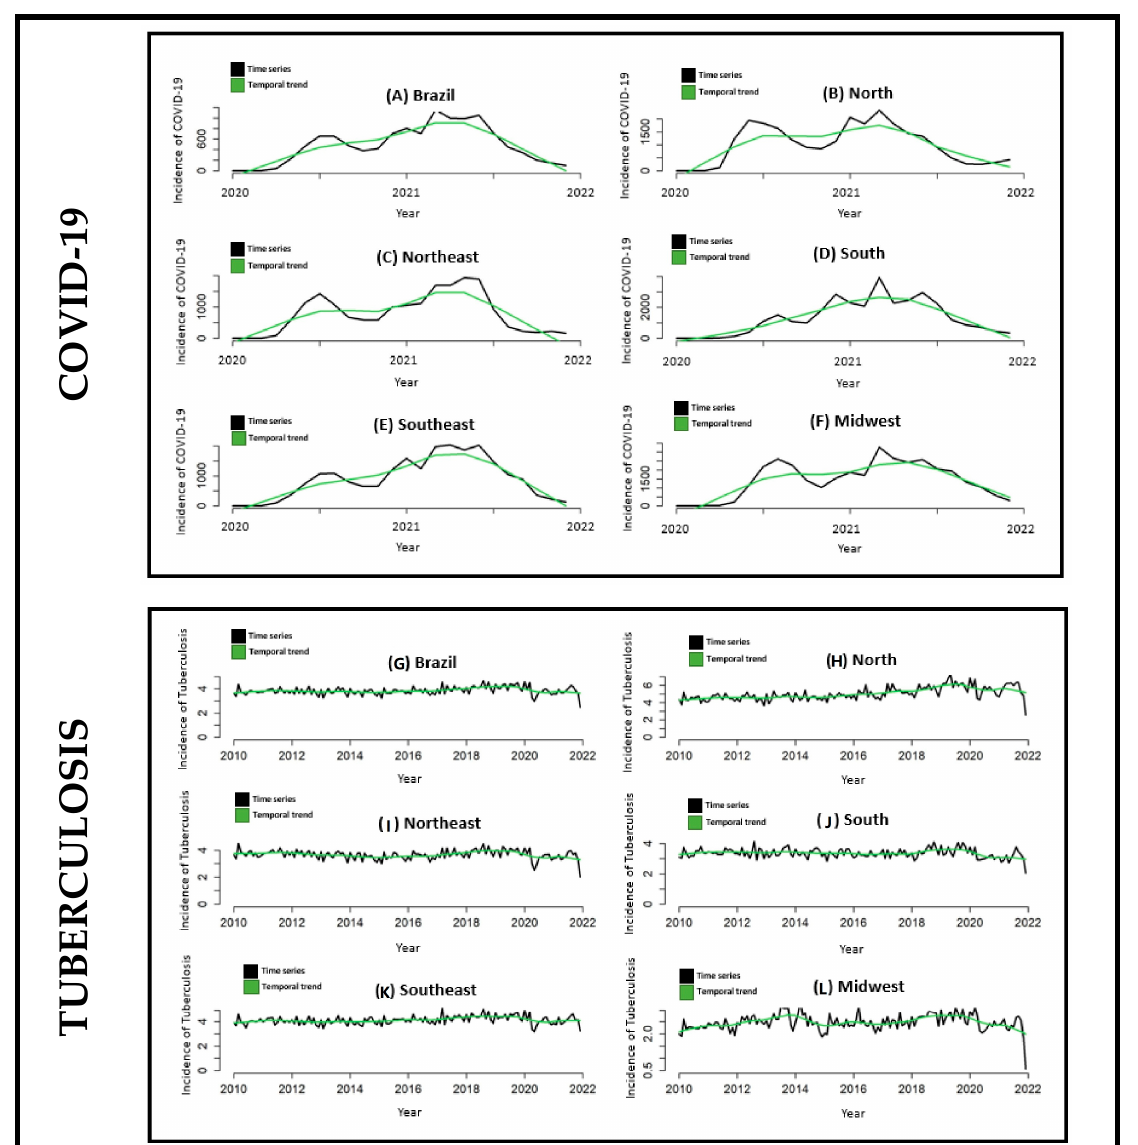
Figure 1. Monthly time series and temporal trend of the notification of COVID-19 and tuberculosis in Brazil and its macro-regions (2020–2021). Legend: ( A )-Notification rate (black line) and temporal trend (green line) of COVID-19 in Brazil. ( B )-Notification rate (black line) and temporal trend (green line) of COVID-19 in the North Region of Brazil. ( C )-Notification rate (black line) and temporal trend (green line) of COVID-19 in the Northeast Region of Brazil. ( D )-Notification rate (black line) and temporal trend (green line) of COVID-19 in the South Region of Brazil. ( E )-Notification rate (black line) and temporal trend (green line) of COVID-19 in the Southeast Region of Brazil. ( F )-Notification rate (black line) and temporal trend (green line) of COVID-19 in the Midwest Region of Brazil. ( G )-Notification rate (black line) and time trend (green line) of Tuberculosis in Brazil. ( H )-Notification rate (black line) and time trend (green line) of Tuberculosis in North Region of Brazil. ( I )-Notification rate (black line) and temporal trend (green line) of Tuberculosis in the Northeast Region of Brazil. ( J )-Notification rate (black line) and time trend (green line) of Tuberculosis in South Region of Brazil. ( K )-Notification rate (black line) and temporal trend (green line) of Tuberculosis in the Southeast Region of Brazil. ( L )-Notification rate (black line) and time trend (green line) of Tuberculosis in the Midwest Region of